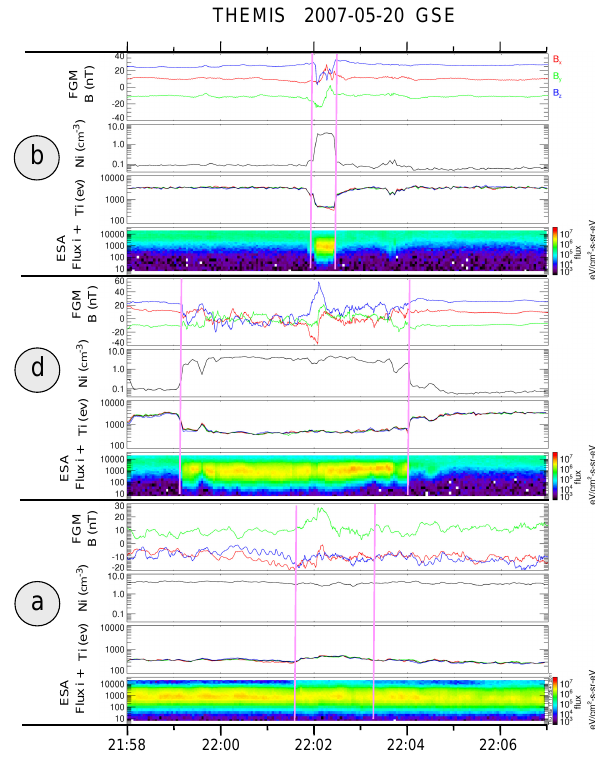
Fig. 2. Composite showing 3 sets of 3 panels. Each set corre- sponds to one spacecraft: Thb (top), Thd, (mid) and Tha (lower). Within each set we display data from the fluxgate (top), search coil (mid) and an electron spectrogram from ESA (bottom panel). Large electrons fluxes are observed on Thb and Thd between verti- cal lines. Large fluxes of heated electrons are also observed on Tha (lowest panel). Within the bracketed region, the electron tempera- tures ( T e ∼ 60eV) at Tha, is larger than in the adjacent free MSh ( T e ∼ 35eV). The electron temperature is the same ( T e ≈ 60eV) within the 3 bracketed regions, for Tha, Thb and Thd. Notice that the large fluxes of heated electrons coincide with enhanced wave amplitudes (see text).